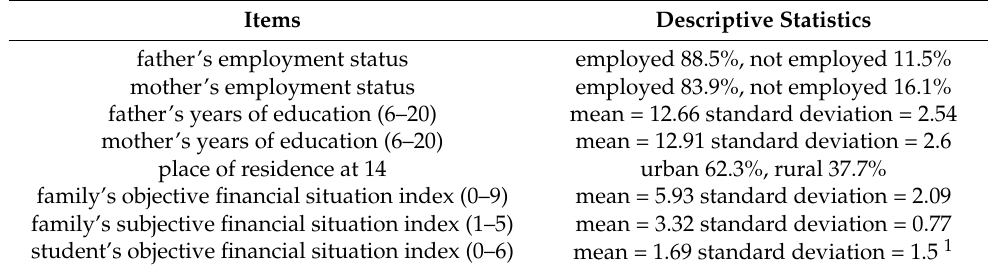
Table 1. Descriptive statistics of the 9 items of the social background index.